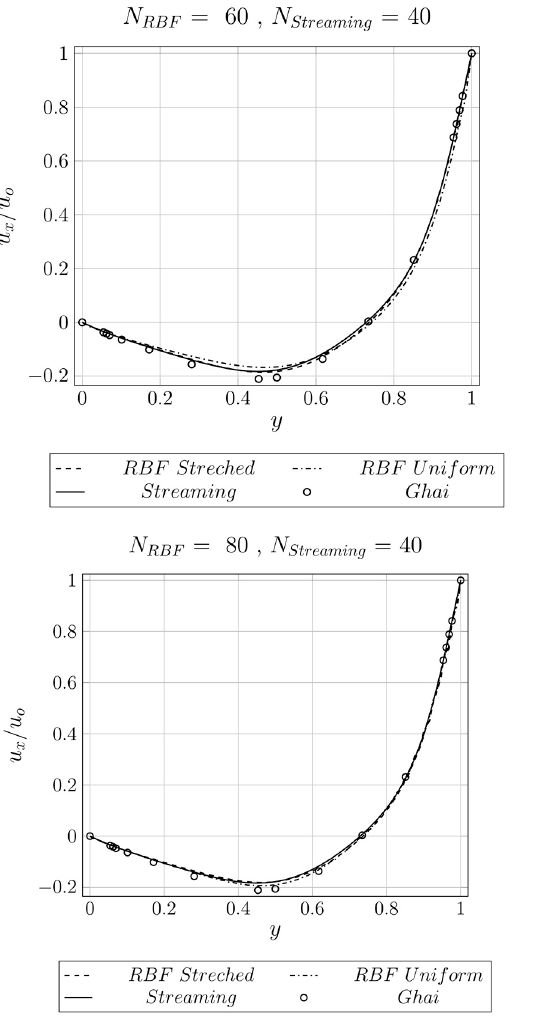
Figure 7. Lid ‐ driven cavity solved using streaming with 40 ‐ mesh and RBF interpolation with 60 ‐ Figure 7. Lid-driven cavity solved using streaming with 40-mesh and RBF interpolation with 60- and and 80 ‐ mesh uniform and stretched. 80-mesh uniform and stretched. As shown in Table 3, the convergence time for the RBF interpolation with the 40-mesh size is greater than that for the streaming for the same size. Increasing the number of grid points to 80 leads to an increase in the convergence time of the RBF interpolation by five times. Nevertheless, the increased computational cost is the price paid for simulating problems with a non-uniform